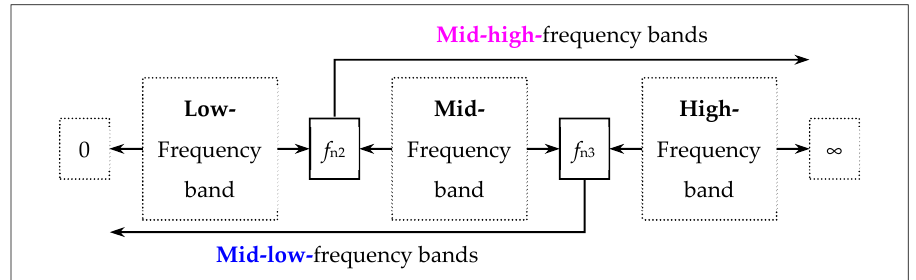
Figure 3. Low-, mid-, and high-frequency bands for AHM-IT-DM-OCA.